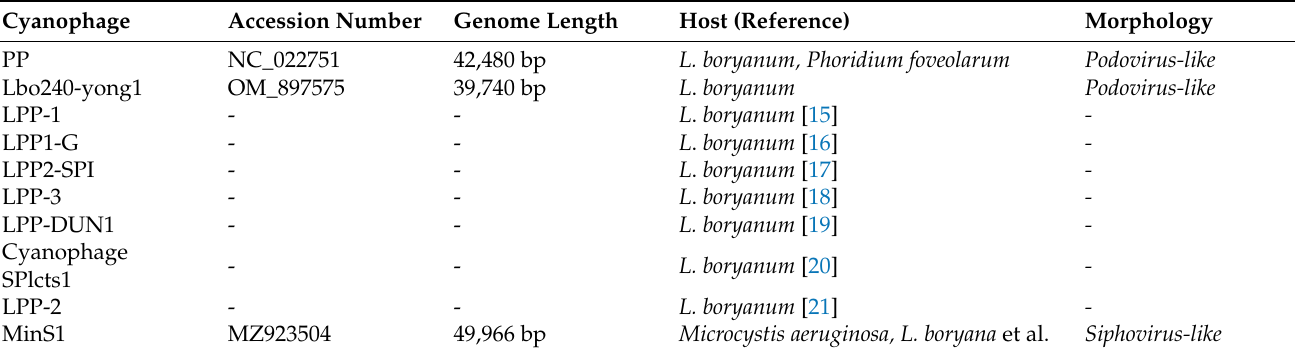
Table 1. A full list of reported cyanophages capable of infecting Leptolyngbya